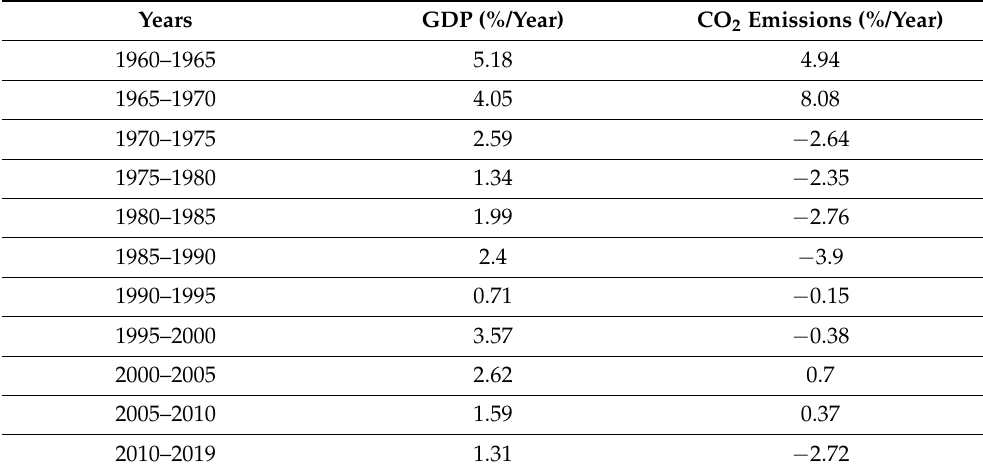
Table 1. Annual changes in Sweden’s CO 2 emissions and changes in GDP: 1960–2019. Average annual growth rates in %. Source: [45–49].